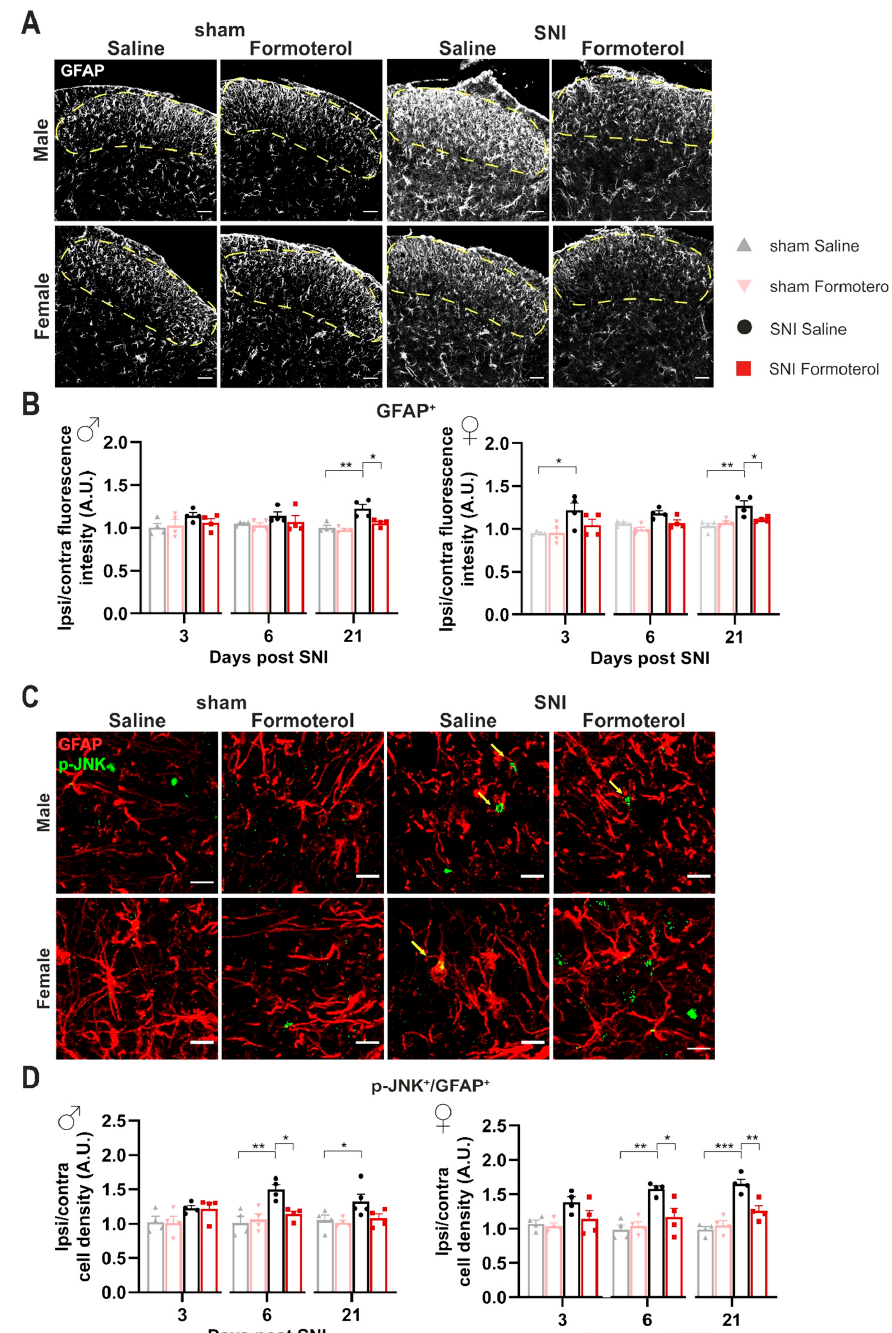
Figure 5. Spinal astroglial cells response to Formoterol in SNI-operated wild-type mice. ( A ) Examples of GFAP immune reactivity in the ipsilateral spinal dorsal horn (SDH) 21 days after nerve injury in male and female WT mice who received saline or Formoterol injection. Scale bar = 60 µ m. ( B ) Analysis of GFAP fluorescent intensity of male (left; day 3: F1, 12 = 1.097, p = 0.3156; day 6: F1, 12 = 0.9393, p = 0.3516; day 21: F1, 12 = 5.003, p = 0.0451) and female (right; day 3: F1, 12 = 1.835, p = 0.2005; day 6: F1, 12 = 0.4848, p = 0.4995; day 21: F1, 12 = 8.059, p = 0.0149) WT mice treated with saline or Formoterol, 3, 6 and 21 days after the operation. Ipsi/contra fluorescent intensity = ratio between values of fluorescent intensity obtained from the ipsilateral and